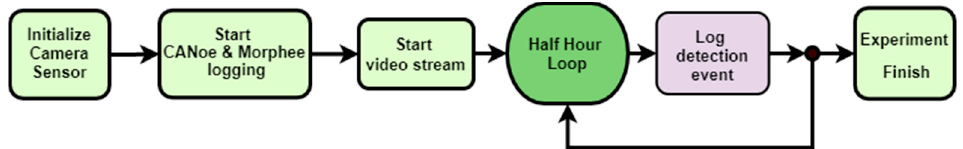
Figure 5. Flow chart of test for the experimental verification of measurement capabilities of the HiL system.